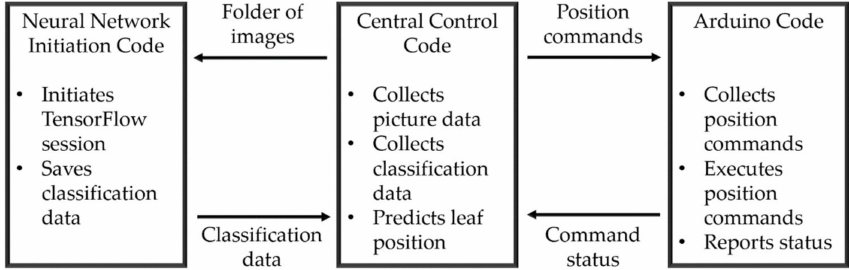
Figure 4. The software architecture used to collect the data required to make plant leaf position estimations. The neural network initiation code was called from the central control code by importing it as a library. Using the command status communications from the Arduino, the central control code could know the current position of the camera and probing arm, and thus know when to take a picture or initiate a chemical measurement.